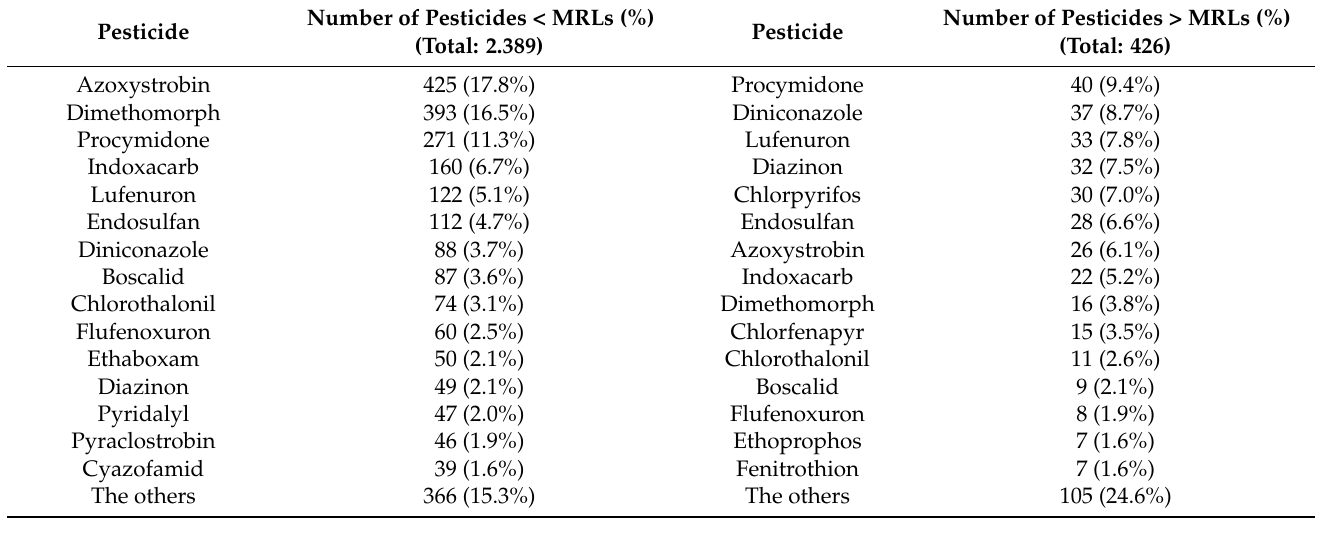
Table 4. Pesticides most frequently detected (number of pesticides <MRLs (%) and >MRLs (%)) in the samples analyzed in our study from 2005 to 2019.